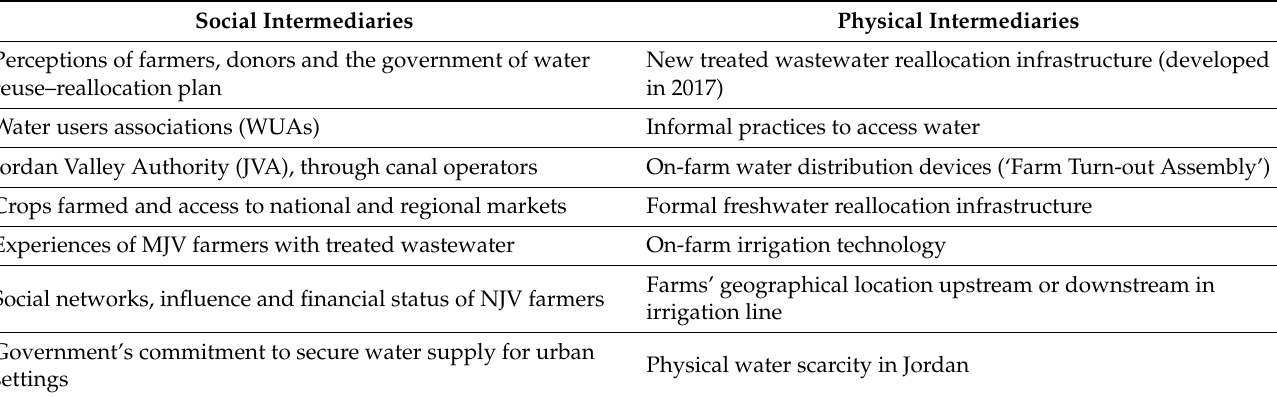
Table 5. Social and physical intermediaries of irrigation water access and allocation in the Northern Jordan Valley (NJV).